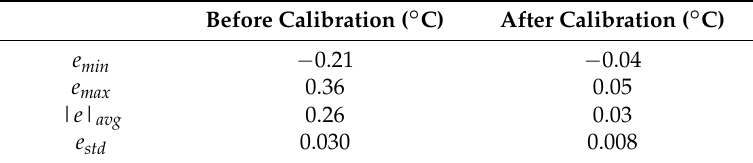
Table 8. Quantitative metrics for the assessment of the measurement system’s